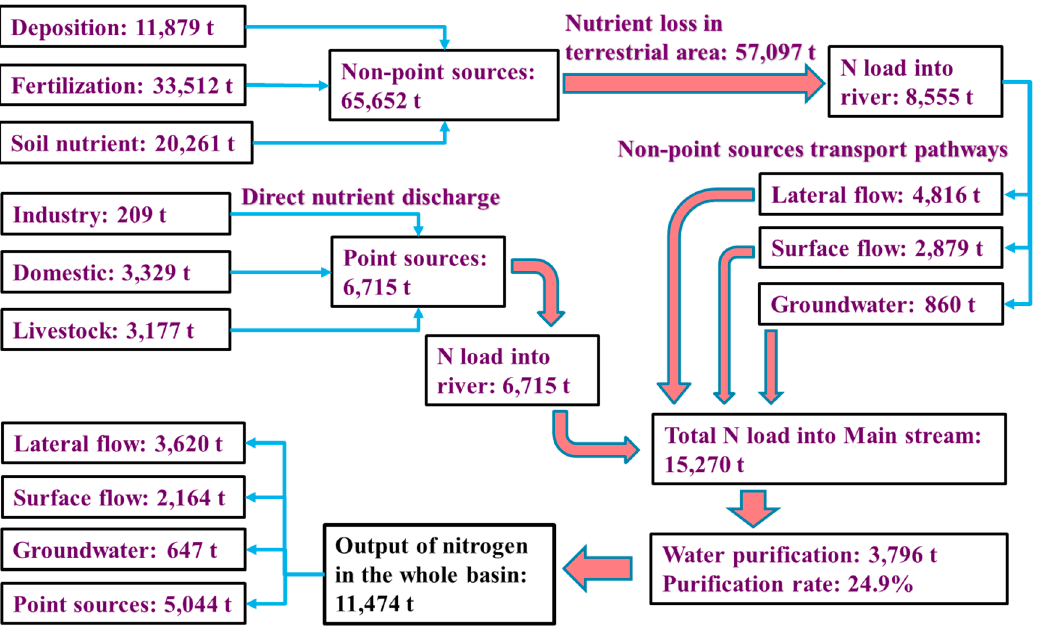
Figure 10. Diagrammatic representation of the area-averaged N budget of the QLB during the period from 2007 to 2016. Blue arrows represent net N inputs and pink arrows represent net N outlets and in-basin consumption. Note that rainfall N deposition here represents all deposition from every land use across the basin, including the water body component.